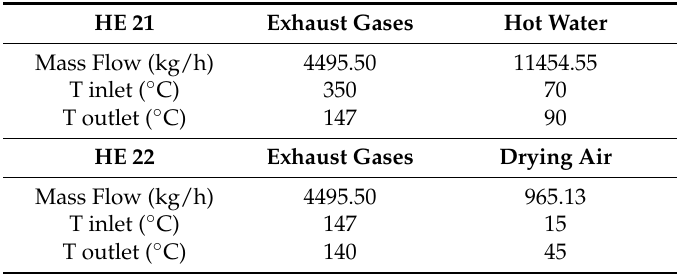
Table 11. Thermal energy production as from the modeling